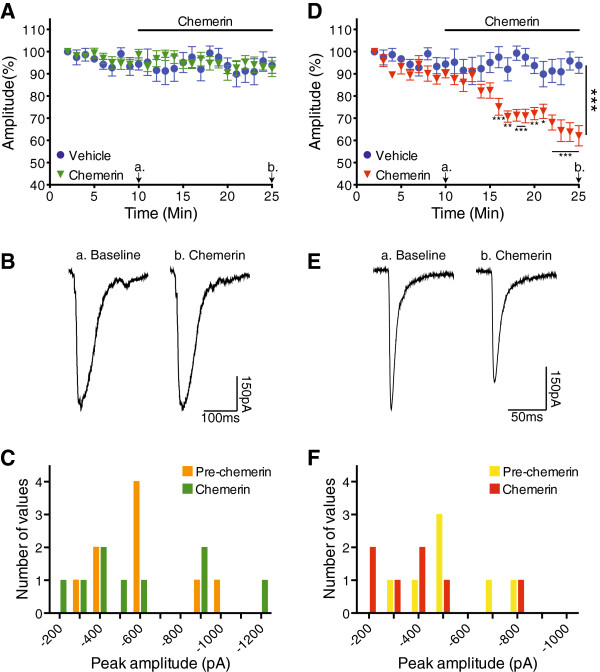
Chemerin attenuates C-fibre input to a subset of lamina I NK1R+ neurons in CFA inflammation. A. Chemerin has no effect on the peak amplitude of monosynaptic C-fibre eEPSCs in the population of neurons classified as ‘non-responders’ (P = 0.802, 2-way repeated measures ANOVA, representative traces shown in B). In this subgroup of non-responders, chemerin did not alter the distribution of actual C-fibre eEPSC peak amplitudes (P = 0.983, paired t-test, C). D. In the subgroup of chemerin responders, chemerin significantly reduces the C-fibre eEPSC amplitude (P = 0.001, 2-way repeated measures ANOVA, representative traces shown in E). Furthermore, in neurons classified as chemerin responders, chemerin resulted in a significant leftward shift in the distribution of actual C-fibre eEPSC peak amplitudes (P = 0.028, paired t-test, F). Example traces show an average of 3 sweeps, baseline and chemerin traces recorded at points ‘a.’ and ‘b.’ respectively, denoted by arrows on relevant graphs. Vehicle n = 7, chemerin responders n = 7, chemerin non-responders n = 9. Data displayed as mean ± SEM. ∗ P < 0.05, ∗∗ P < 0.01, ∗∗∗ P < 0.001.